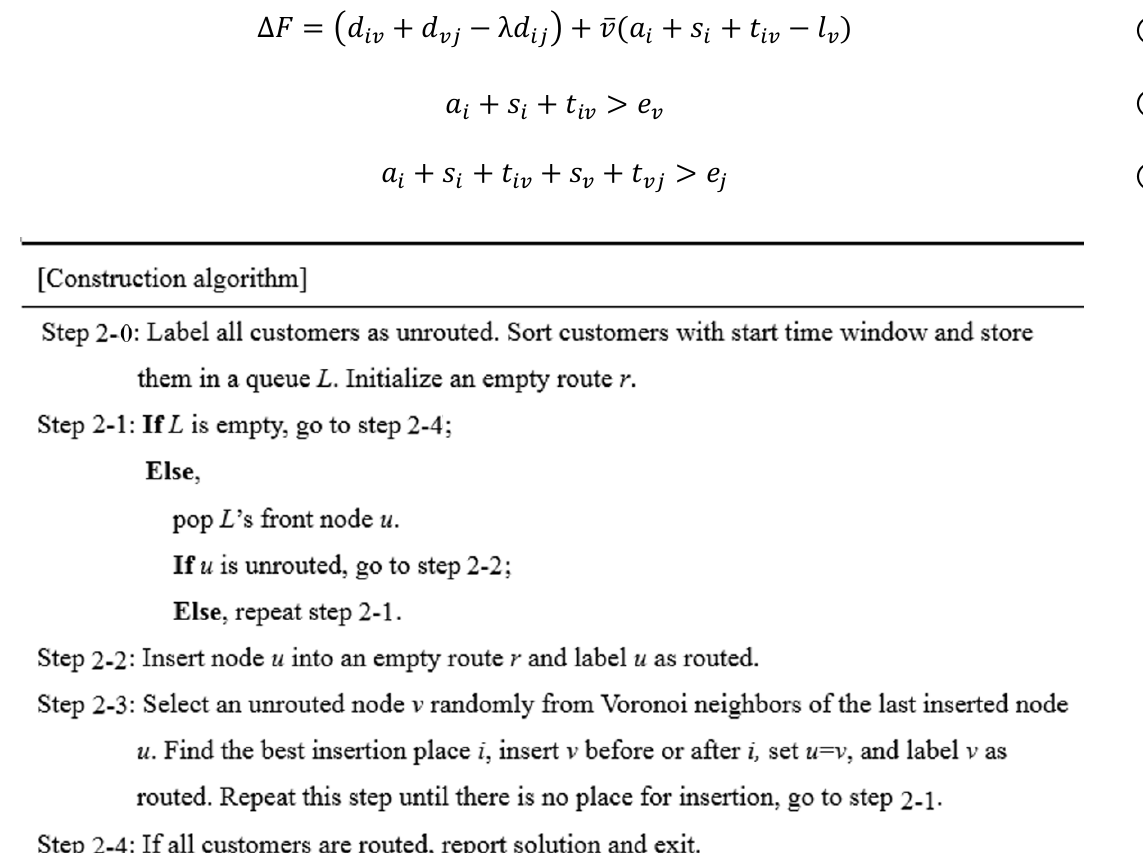
Figure 4. The construction